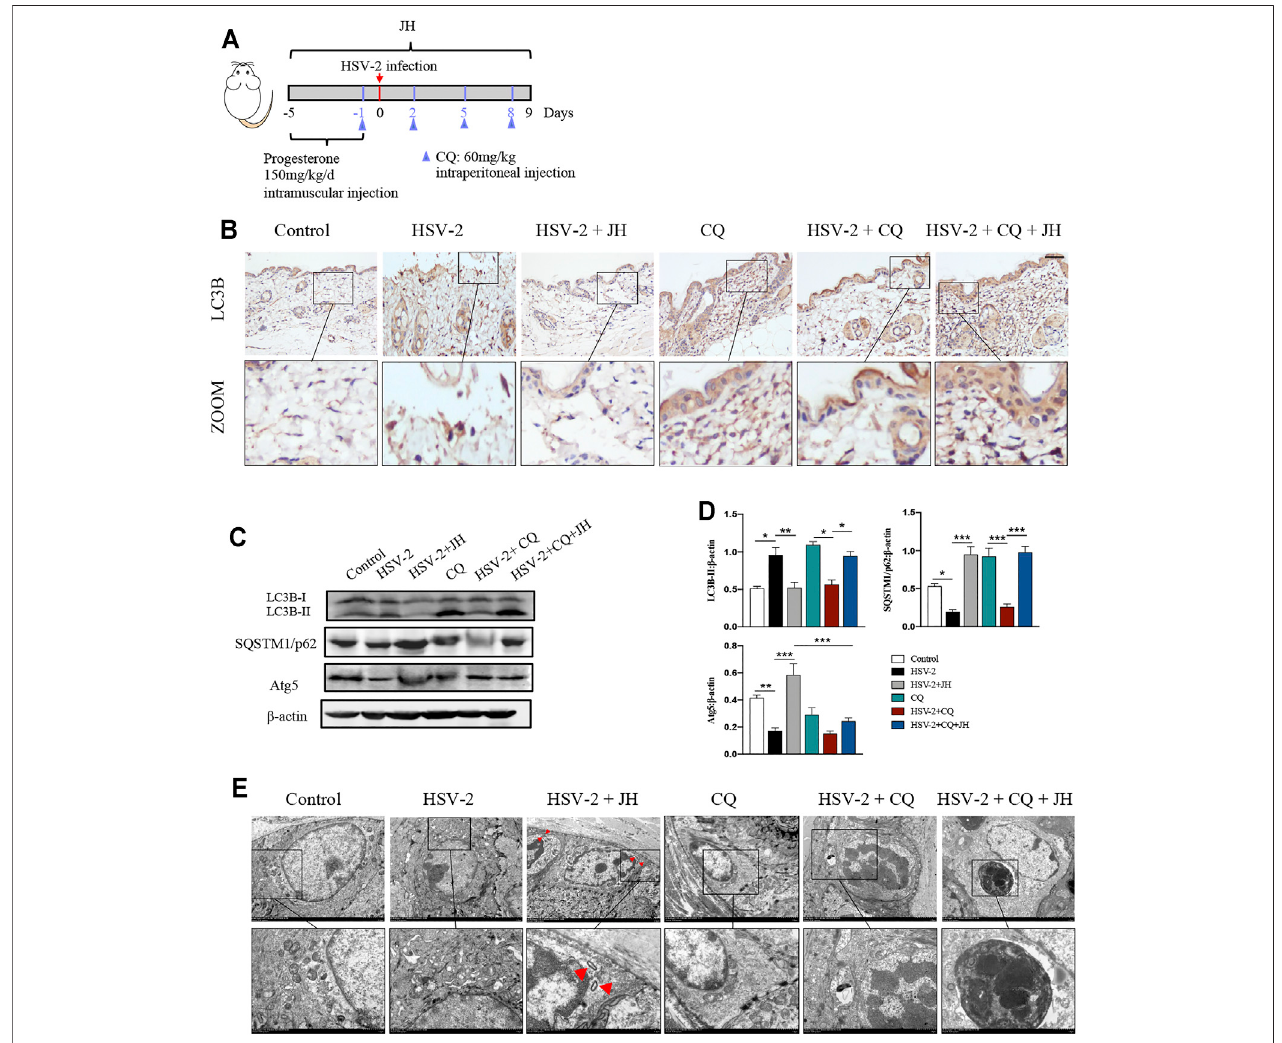
FIGURE 5 | HSV-2 infection leads to a blockage of autophagic fl ux in vivo and JZ-1 administration induces autophagy in HSV-2-induced GH. (A) The protocol of administration of CQ in animal experiment. (B) Representative immunohistochemistry staining for LC3B in vulva of different groups. (C) Representative western blot for LC3B-II,SQSTM1/p62andAtg5proteinexpressionsinvulva. (D) Thequanti fi cationofLC3B-II,SQSTM1/p62andAtg5westernblot. (E) TEMofdifferentgroupsinvulva (the red arrow indicates the autophagy structure). All data are presented as means ± SEM. p < 0.01 (**), and p < 0.001 (***); ( n (cid:2)